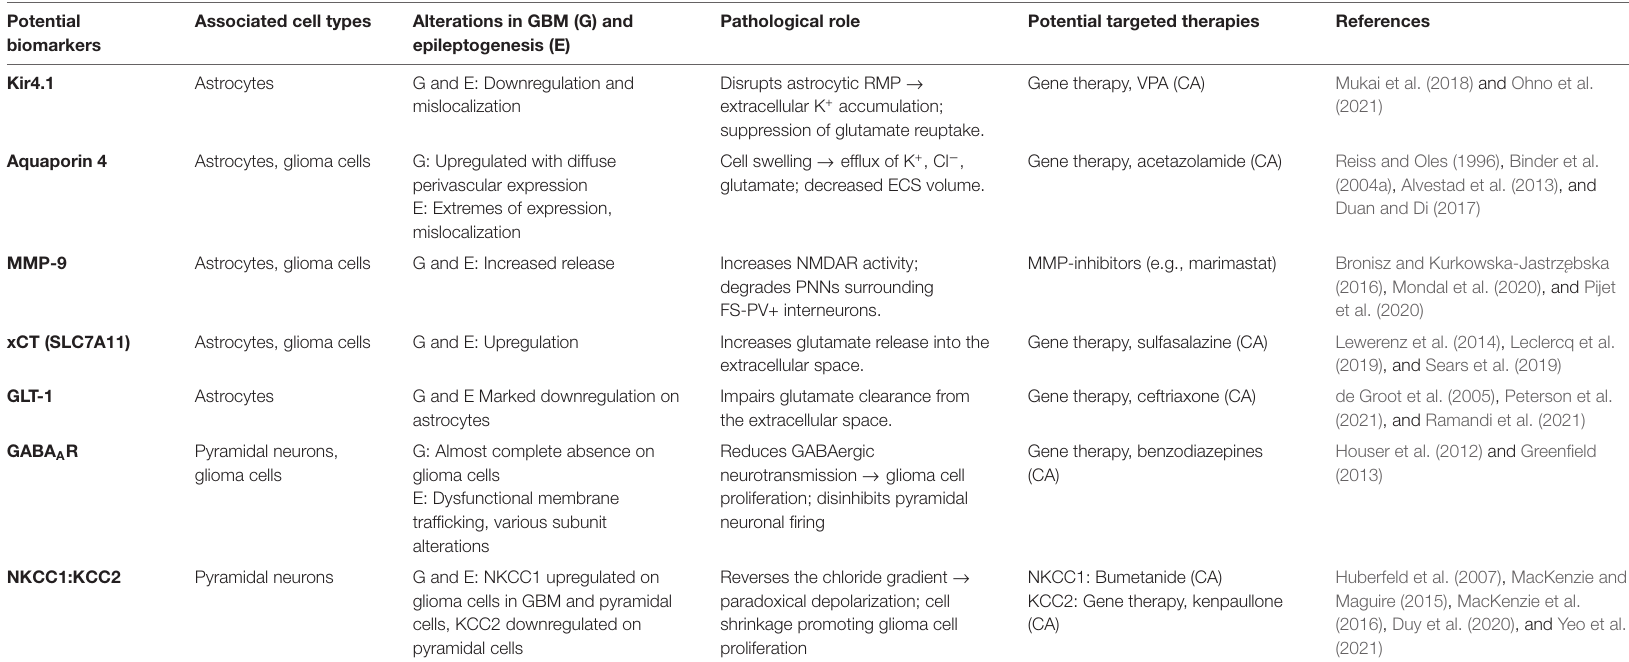
TABLE 1 | Potential biomarkers in GBM-associated epilepsy, their relationship to each pathology, role, and potential targeted therapies. Potential